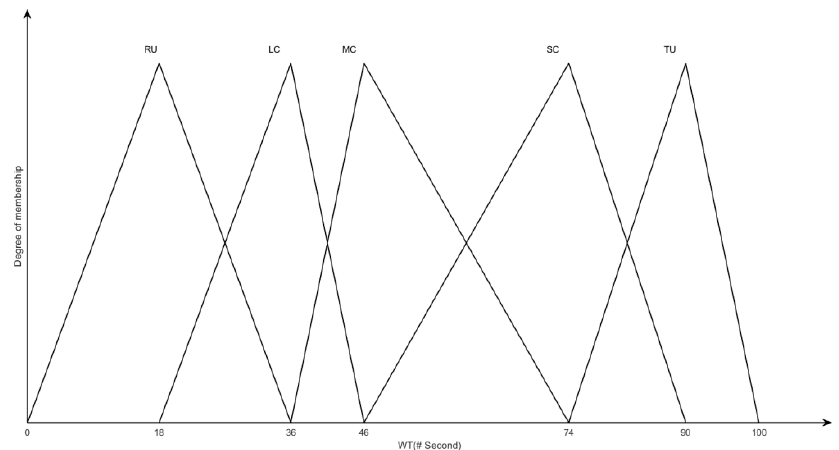
Figure 2. The input fuzzy membership of the fuzzy logic system.